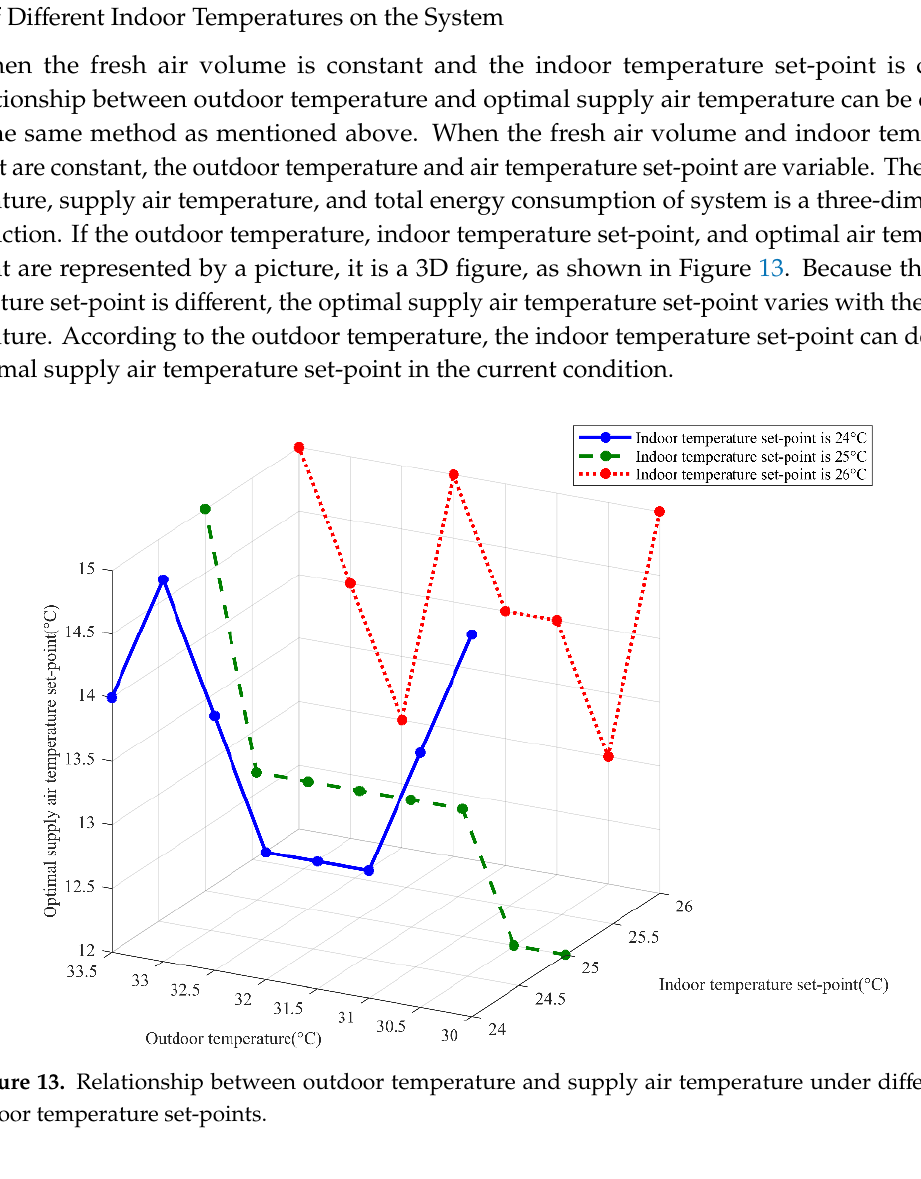
Figure 12. Optimal supply air temperature when indoor temperature set-point is 24 °C. E ff ect of Di ff erent Indoor Temperatures on the System